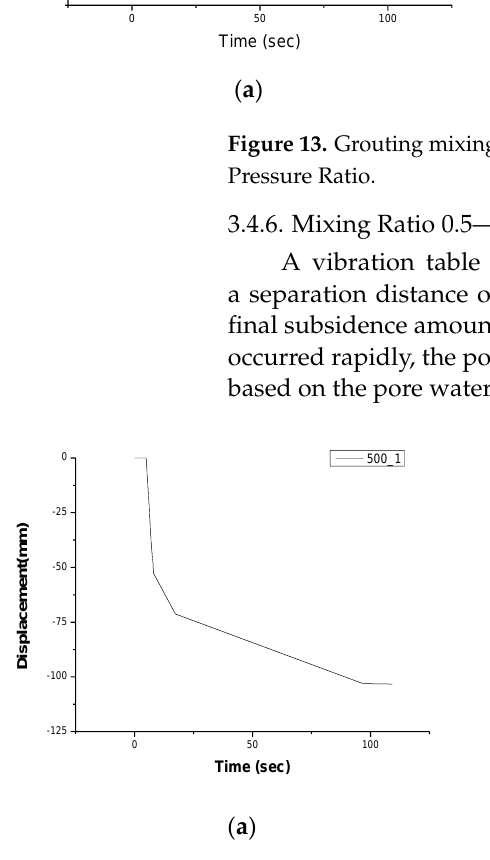
Figure 14. Grouting mixing ratio of 0.5 and separation distance of 1 cm: ( a ) Settlement ( b ) Pore Water Pressure Ratio.